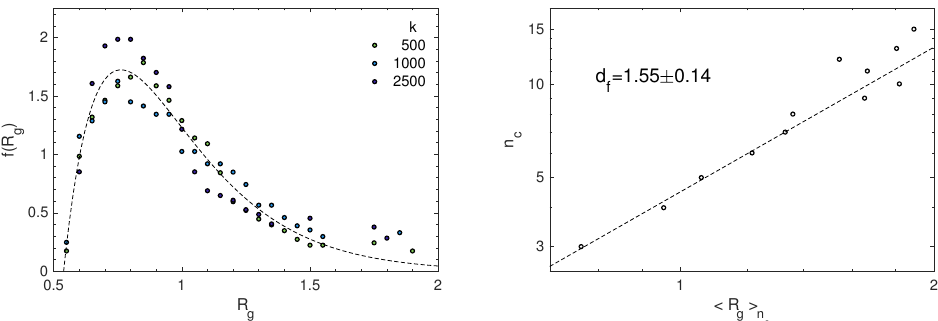
Figure 6. ( Left ) distribution of the radius of gyration of soft clusters. The dashed line is a guide for the eyes. ( Right ) correlation plot between the number of members of a cluster n c and the gyration radius averaged over all the clusters with the same number of members, fit curve with the power-law, Equation (13), by adopting a linear least-squares procedure with weights proportional to the number of clusters involved in each average to draw dimension is d f = 1.55 ± 0.14. If no weight is used, one finds d (cid:48)